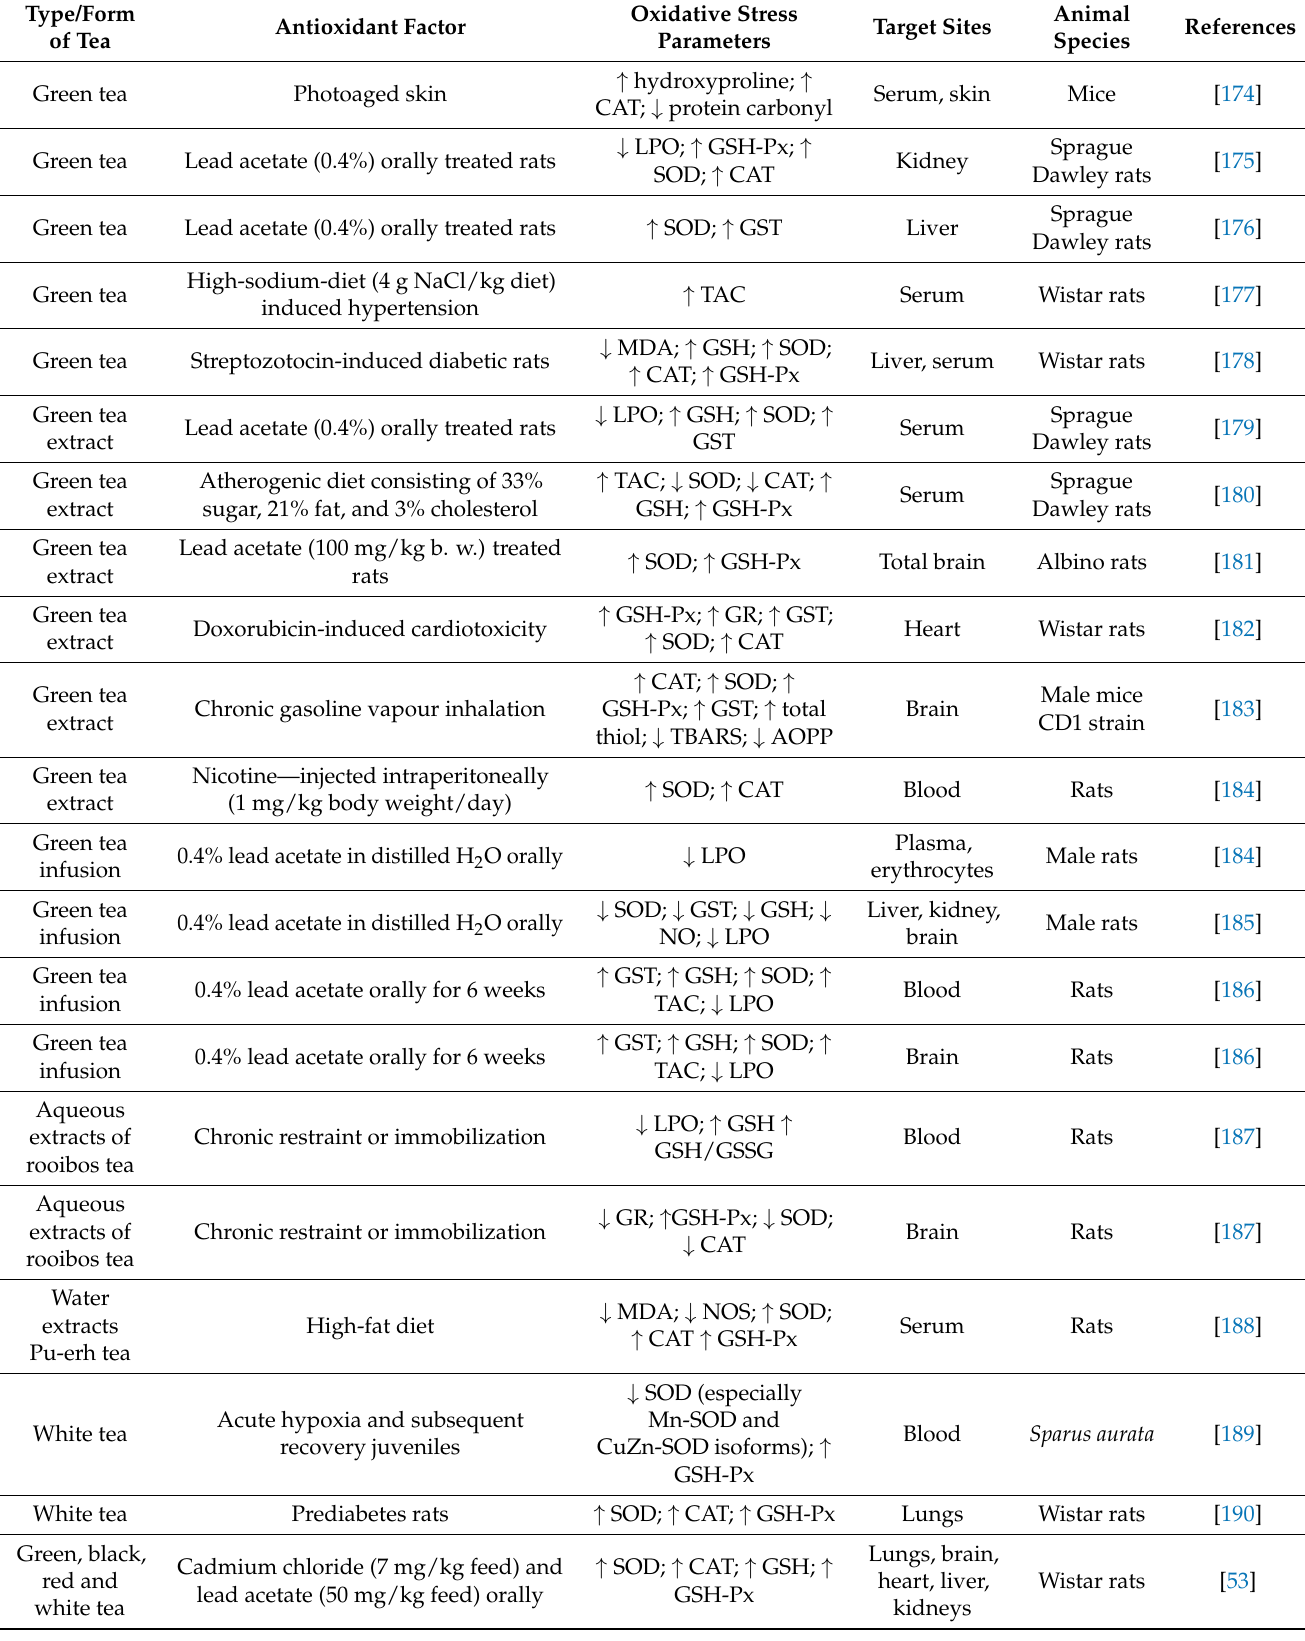
Table 2. Antioxidant effects of tea and tea active compounds—review of studies on laboratory